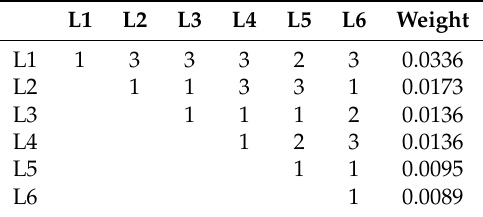
Table A3. Pairwise comparison matrix of Quality of Life.